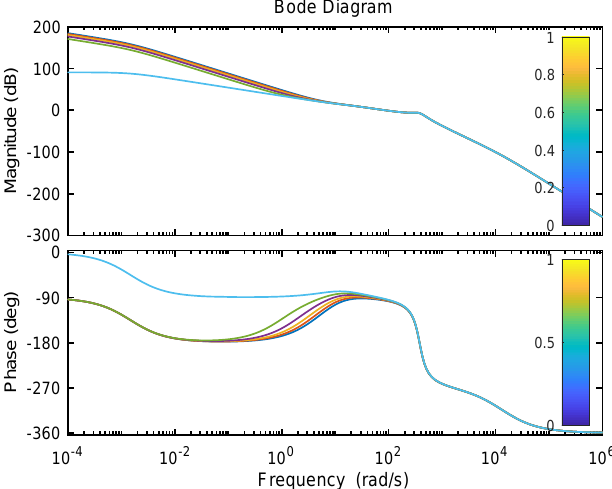
Figure 10. The bode diagram under the different K i